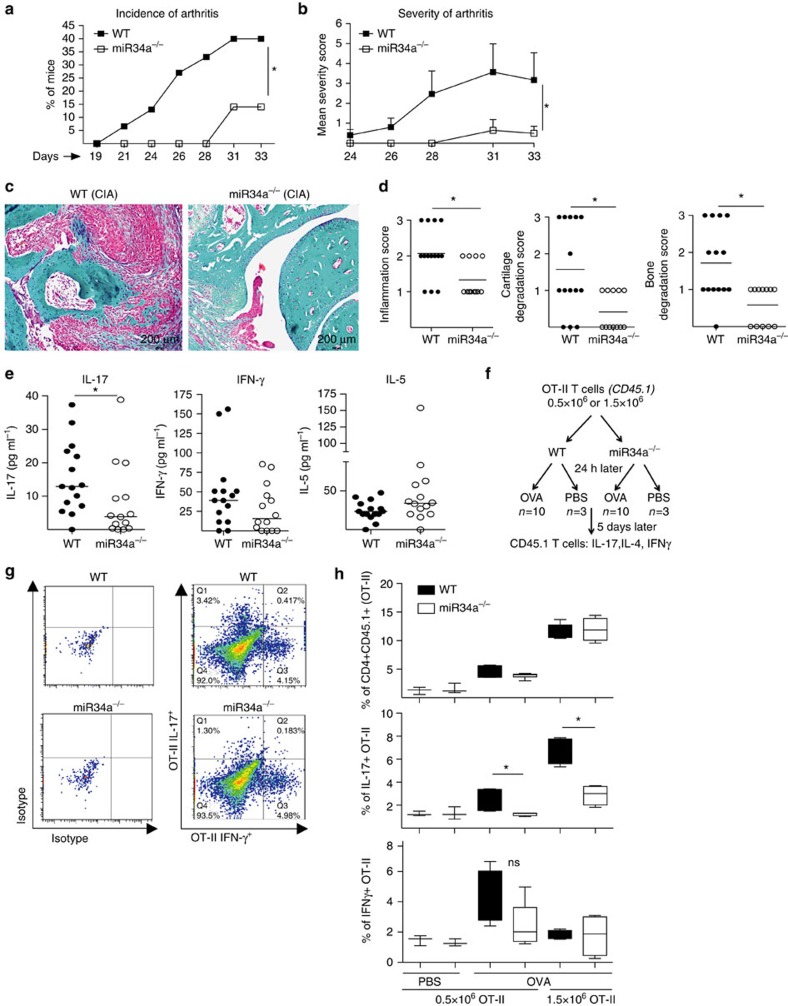
MiR-34a−/− mice are resistant to arthritis.(a–e) WT (n=15) and miR-34a−/−(n=14) mice were sensitized according to the protocol in Methods. Mice were monitored for disease onset and paw swelling from day 10. Mice were killed on day 33 and tissue samples harvested. (a,b) miR-34a−/− mice had a reduced incidence (a) and severity (b) of arthritis; P< 0.05 two-way ANOVA; severity data are presented as mean±s.d. (c,d) miR-34a−/− mice had reduced joint pathology. (c) Representative histology of typical WT and miR-34a−/− joints. Tissue sections (WT, n=15; miR-34a−/−, n=14) were stained with trichrome (cartilage and bone collagen stained turquoise) and H&E (red; inflammatory synovium). (d) Quantitative evaluation of synovial inflammation, and cartilage and bone degradation showed reduced scores for miR-34a−/− mice. (e) MiR-34a−/− CIA mice showed reduced concentrations of IL-17 in the serum compared to WT, but no difference in interferon-gamma (IFNγ) or interleukin (IL)-5. Data are presented as dot-plots with median; (d,e) *P<0.05, Mann–Whitney u-test. (f) Schematic description of the adoptive transfer of OT-II OVA-specific T cells into WT (n=13) and miR-34a−/− (n=13) mice. (g,h) After adoptive transfer of OVA-specific T cells, miR-34a−/− mice showed reduced development of antigen-specific IL-17-producing cells compared to WT recipients. Representative dot-plot representation (g) and quantitative evaluation (h) of total antigen-specific cells and IL-17/IFNγ producing cells in WT and miR-34a−/− recipients are shown. *P<0.05, Mann–Whitney U-test. Data are presented as median±IQR obtained in two independent experiments. ns, not significant.